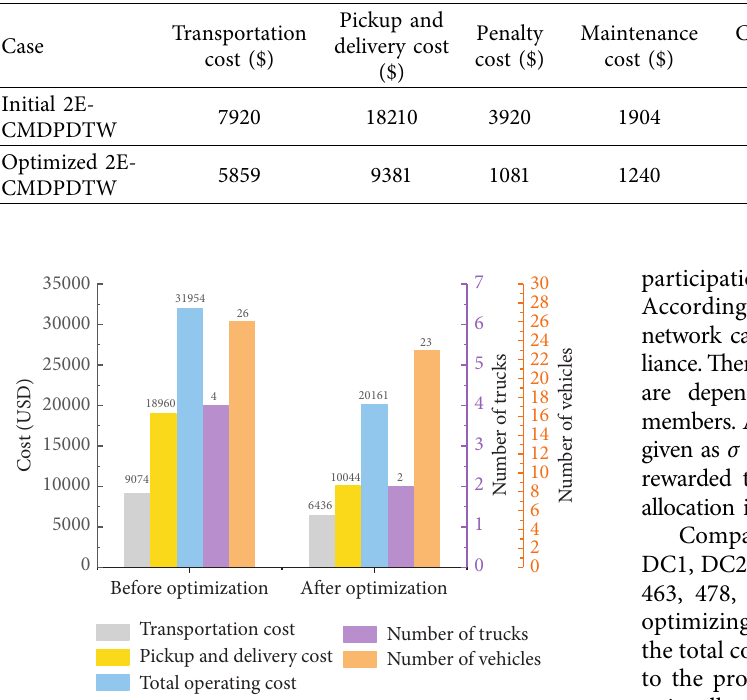
Figure 9: Comparative results of the network before and after establishing the grand